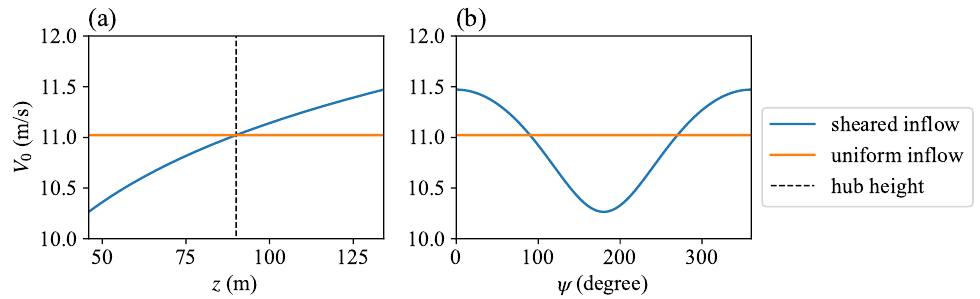
Figure 12. Freestream inflow velocity to the turbine blade section r = 0.7 R at ( a ) different vertical heights and ( b ) different blade phase